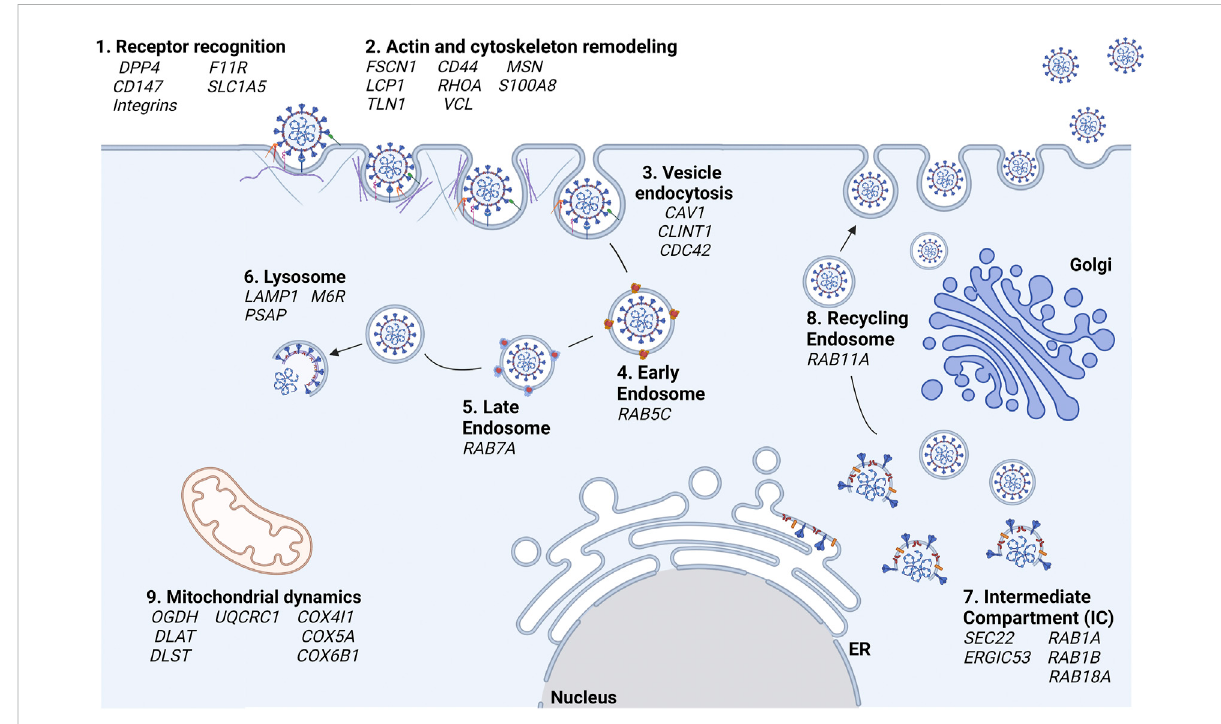
FIGURE 6 Hypotheses of the cellular processes in which S is involved according to proteomics results. In bold black are reported the cellular processes and in italics the associated genes,